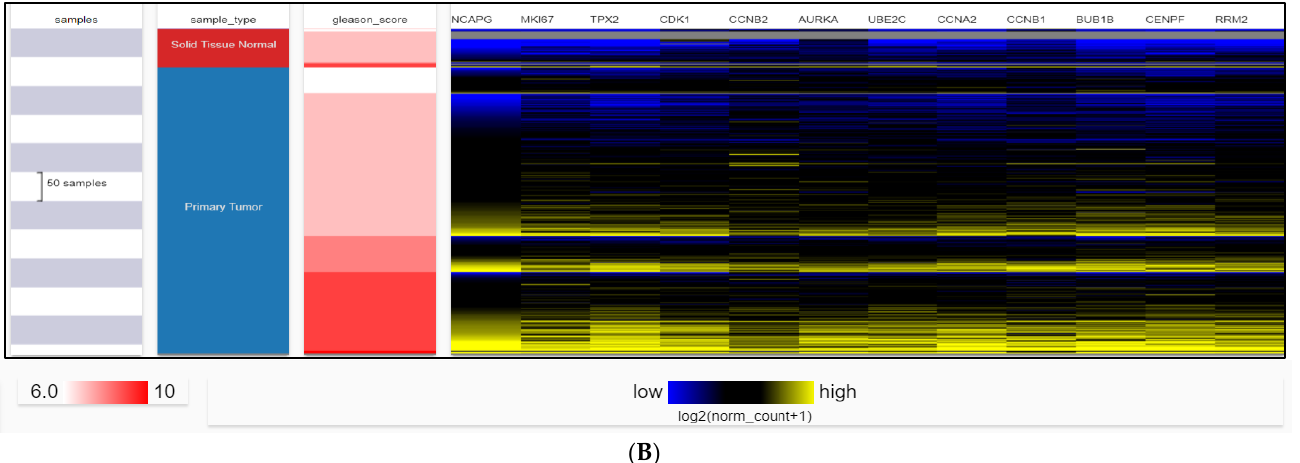
Figure 7. Heat map of 12 hub genes by UCSC-Xena. ( A ) The color parameters adjusted as max color 100% saturation of log2 (norm_count + 1) = 10.4 (yellow); min color 100% saturation of log2 (norm_count + 1) = 2.65 (blue) ( B ) The Gleason score was ranked from 5 (light pink) to 10 (dark pink). The cancer samples are shown in blue, and samples of pink are normal tissue. The high-expressed genes are marked yellow, and the low-expressed genes are blue (log2 (norm_count + 1).